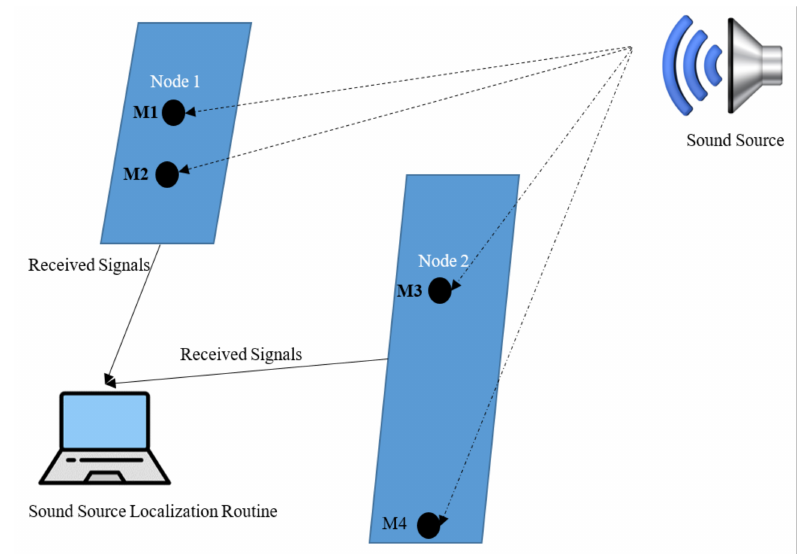
Figure 8. Experimental